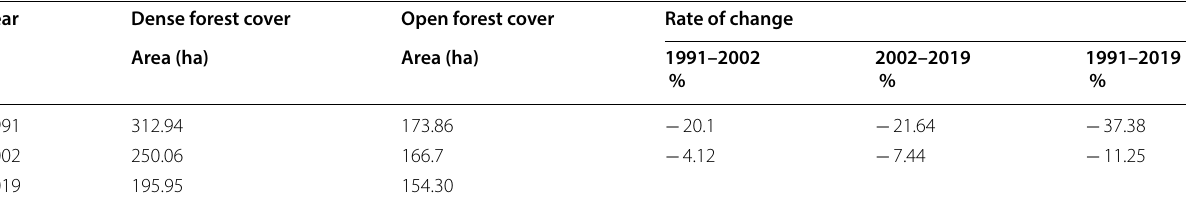
Table 6 Forest cover area of Komto forest and rate of change (1991, 2002, 2019)